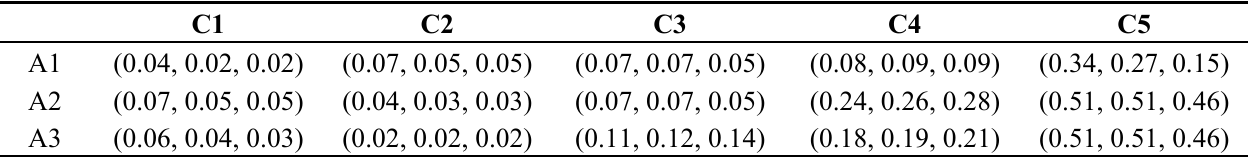
Table 8. The fuzzy grey relational grade.